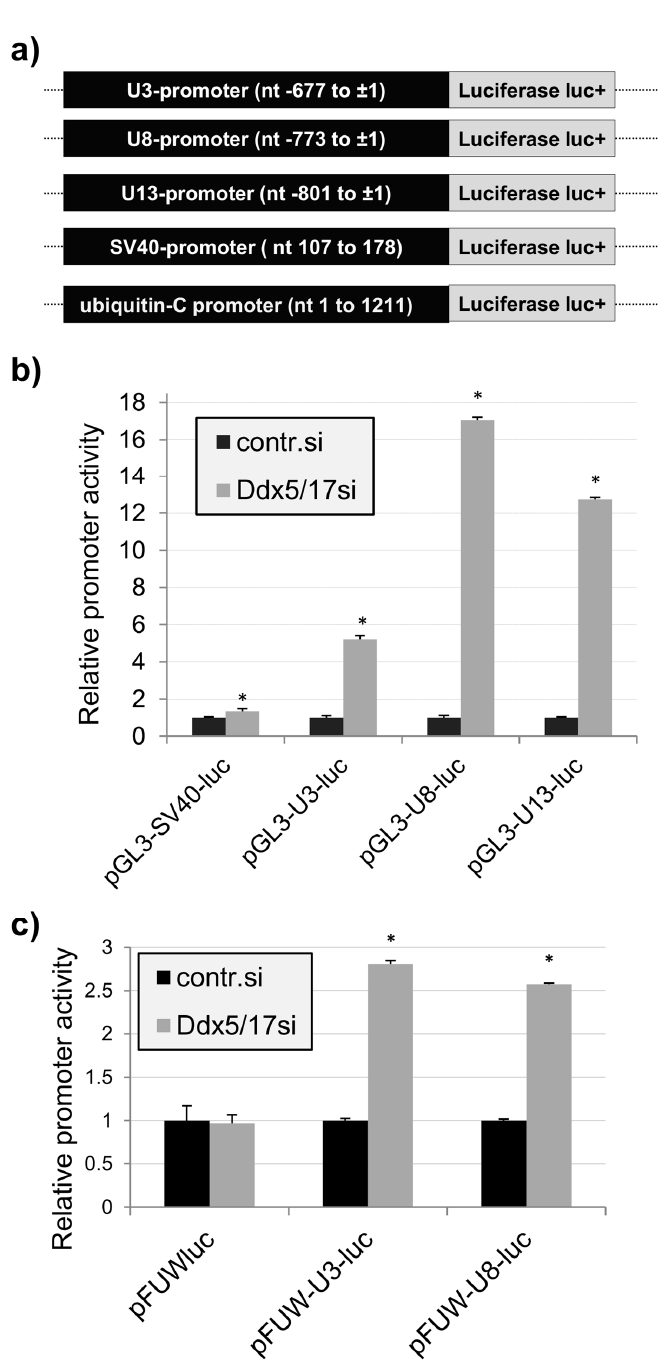
Figure 2. Promoter-dependent regulation of the U3-, U8-, and U13snoRNA expression by Ddx5/Ddx17. ( a ) Schematic drawing of the promoter regions (in black) used for the expression of the promoter-less firefly luciferase gene (in gray) from the respective pGL3-luc expression plasmids (pGL3-U3-luc, pGL3-U8-luc, pGL3-U13-luc, pGL3-SV40-luc) or recombinant lentiviruses (pFUWluc, pFUW-U3-luc, pFUW-U8-luc). The numbers refer to the nucleotides upstream of the respective genomic transcription start sites ( ± 1); ( b ) and ( c ) Expression of firefly luciferase after knockdown of Ddx5/17 (Ddx5/17si) from the pGL3-luc expression plasmids in HEK293 cells ( b ) or from recombinant lentiviruses in HeLa cells ( c ) (mean ± standard deviation (SD); n = 3; * p value < 0.05). Control siRNA (contr.si) was used in parallel experiments. Measured luciferase fluorescence was converted into relative promoter activity units. The construct with the SV40 early promoter (pGL3-SV40-luc) was used as a negative control in ( b ) and that with the human ubiquitin promoter (pFUWluc) in ( c